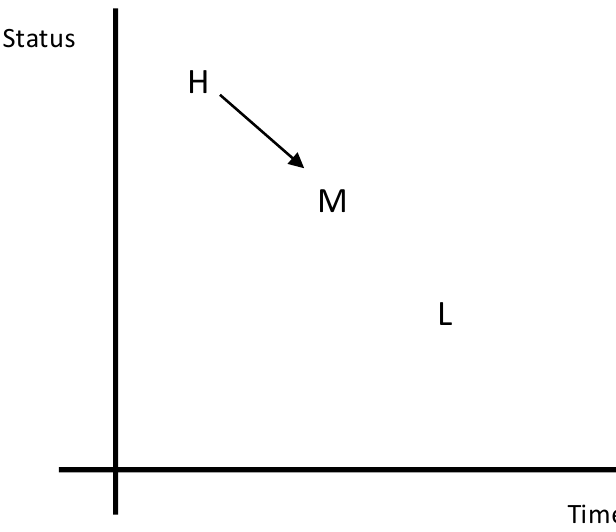
Fig. 4a. High Status Provenance Diffusion Pattern